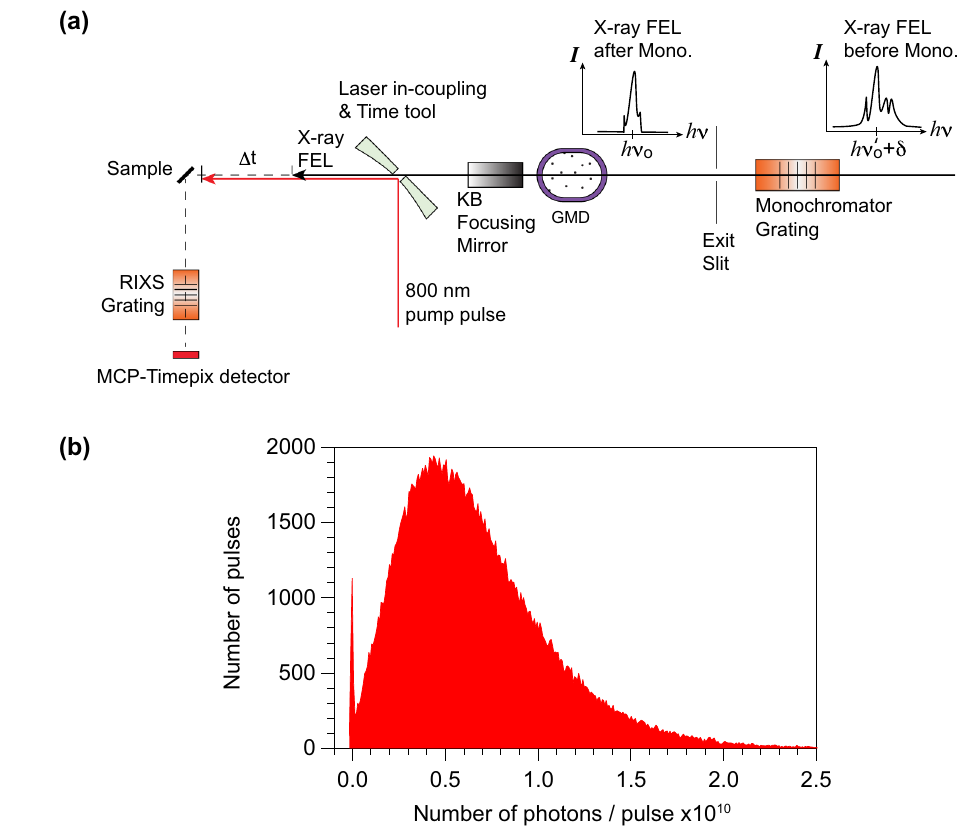
Figure 1. Optical layout of the time-resolved RIXS experiment at the SXR, LCLS beamline. ( a ) A sketch of the experiment setup. The monochromator selects a band pass centered at hν o (set by the grating angle and the exit ′ ν ′ slit size) from the X-ray FEL with a frequency centroid of h ν o and a bandwidth δ. Note that ν o and o are usually not identical due to FEL jitter. The intensity after the monochromator exit slit is measured by the gas monitor detector (GMD). The time tool characterizes the delay time between the optical pump and X-ray FEL pulses. After the sample, a spectrometer equipped with the MCP-Timepix detector captures the RIXS signal in a pulse- by-pulse fashion. ( b ) Histogram of the X-ray FEL intensity (in unit of number of photons per pulse) measured by